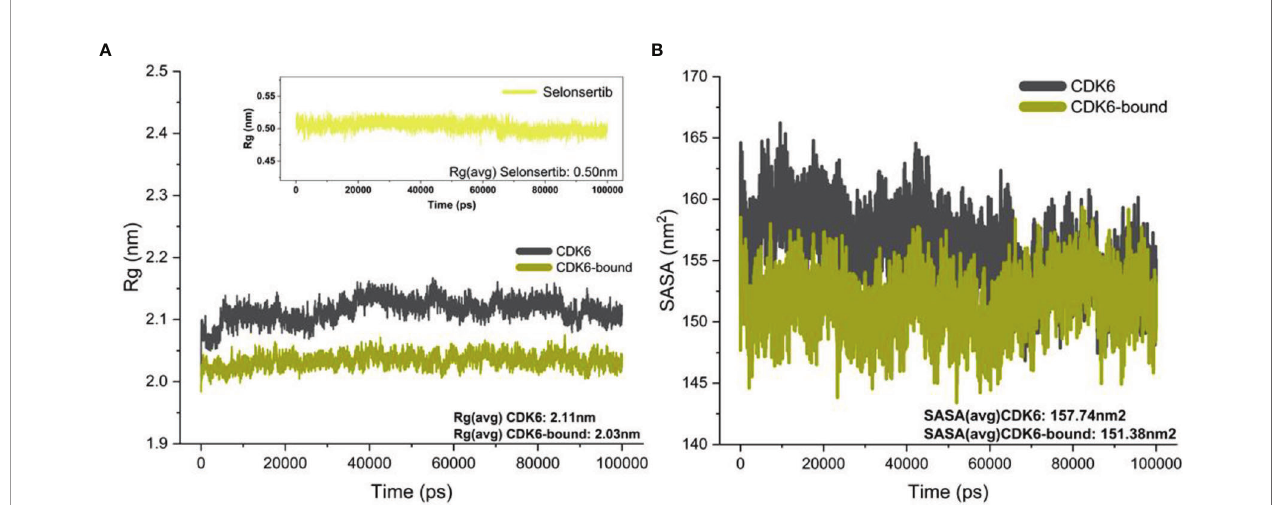
FIGURE 3 | (A) R g of the backbone carbon alpha for the unbound CDK6 protein and CDK6 protein complexed with selonsertib. (B) The SASA (nm 2 ) for the unbound CDK6 protein and CDK6 protein complexed with selonsertib during the 100